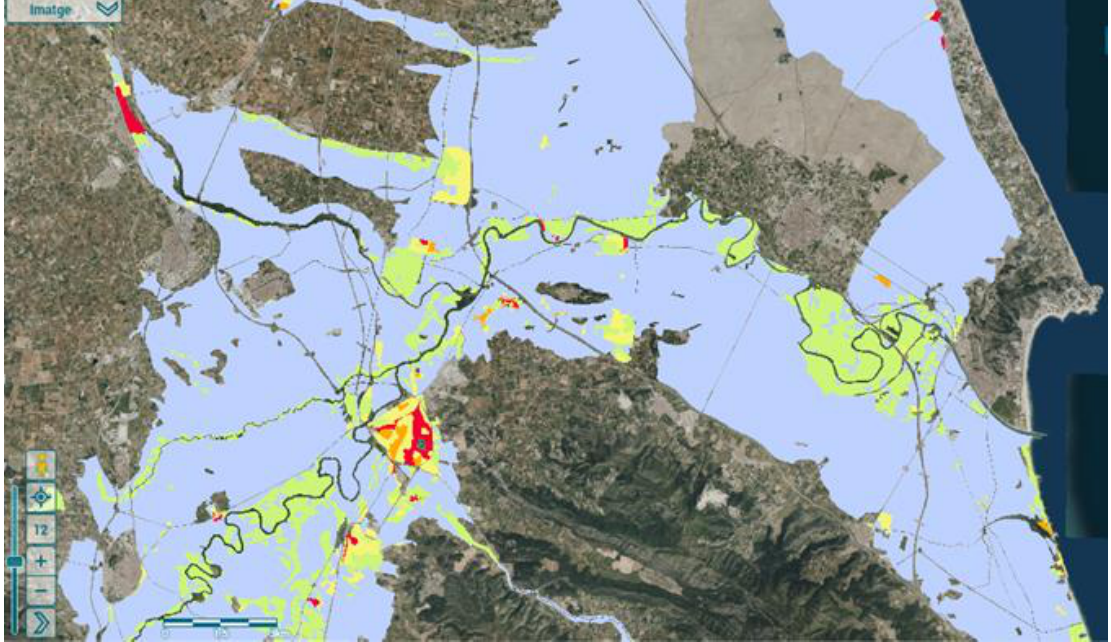
Figure 7. Image capture of the risk layers of the PATRICOVA viewer (mouth of the Júcar river). Source: Valencian Cartographic Institute [53]. Note: Levels of risk: red (“Very high”), orange (“High”), yellow (“Medium”), green (“Low”), blue (“Very low”). The red area coincides with the principal population nuclei. Own elaboration.